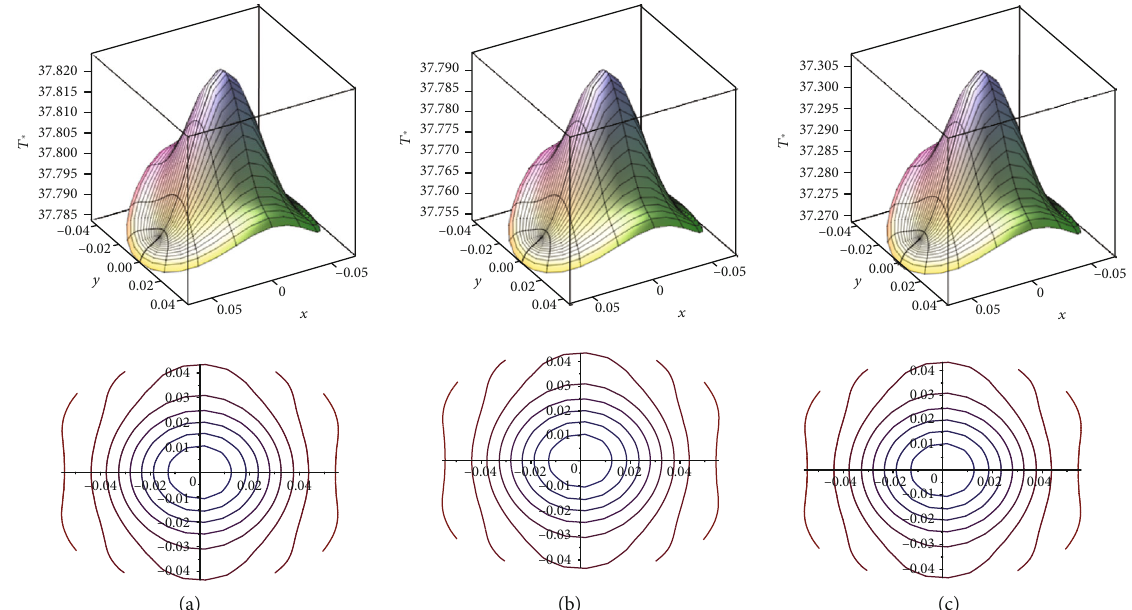
Figure 5: Temperature fi eld at the 30 th wave cycle in the case of the highest positive pressure gradient dp / dz = 2 : 4 for three di ff erent slip lengths: (a) β = 0 : 005 ; (b) β = 0 : 05 ; (c) β = 0 : 07 .